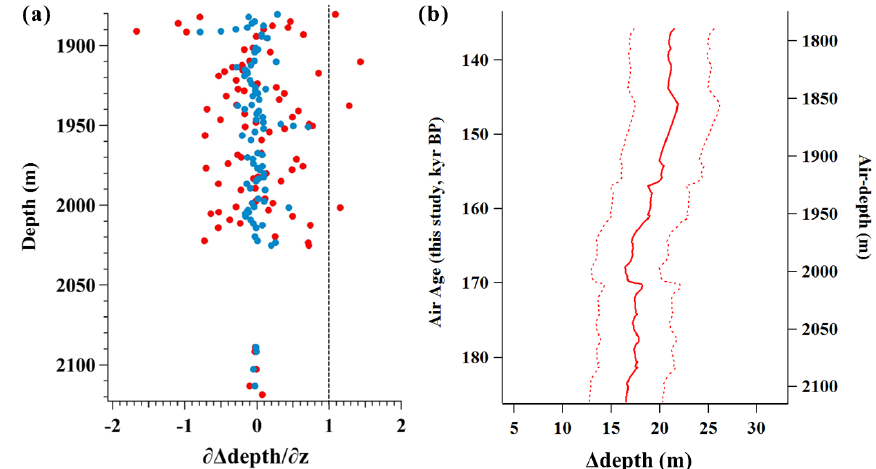
Figure 2. (a) ∂(cid:49) depth /∂z as a function of depth. Red dots represent raw δ 15 N measurements, and blue dots represent a weighted three-point running mean (see text for details). The dashed vertical grey line indicates ∂(cid:49) depth /∂z = 1. (b) (cid:49) depth (bold line) for the EDC ice core from 1787.5 to 1870.2m below the surface, deduced from δ 15 N and the thinning function calculated in this depth range. The two dashed lines correspond to the analytical uncertainties.